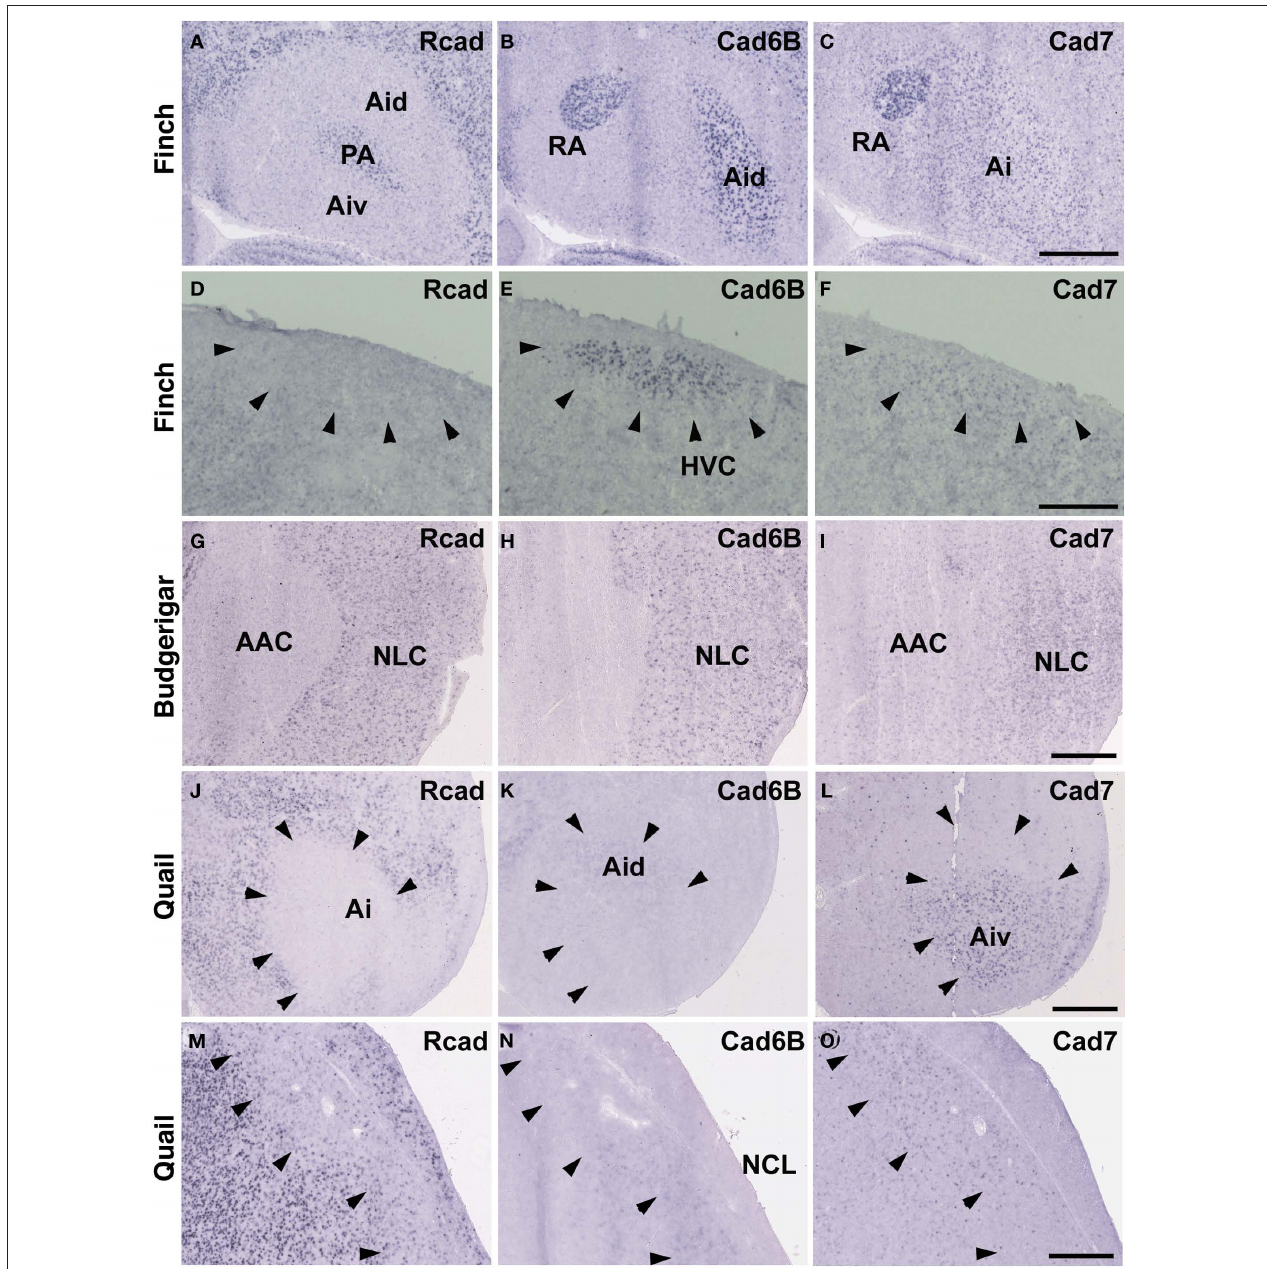
quail in the intermediate arcopallium (Ai) and caudolateral nidopallium (NCL). Arrowheads indicate expression boundary between the strong Rcad expression domain and the strong cad6B and cad7 expression domain. Scale bars are